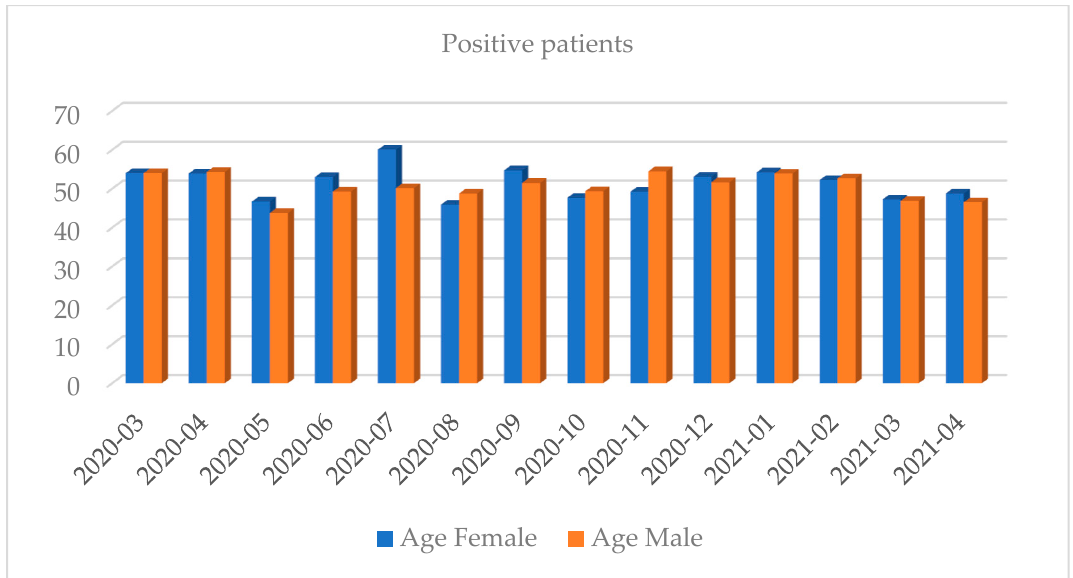
Figure 4. Distribution of positive results by the average age and gender in a given month.